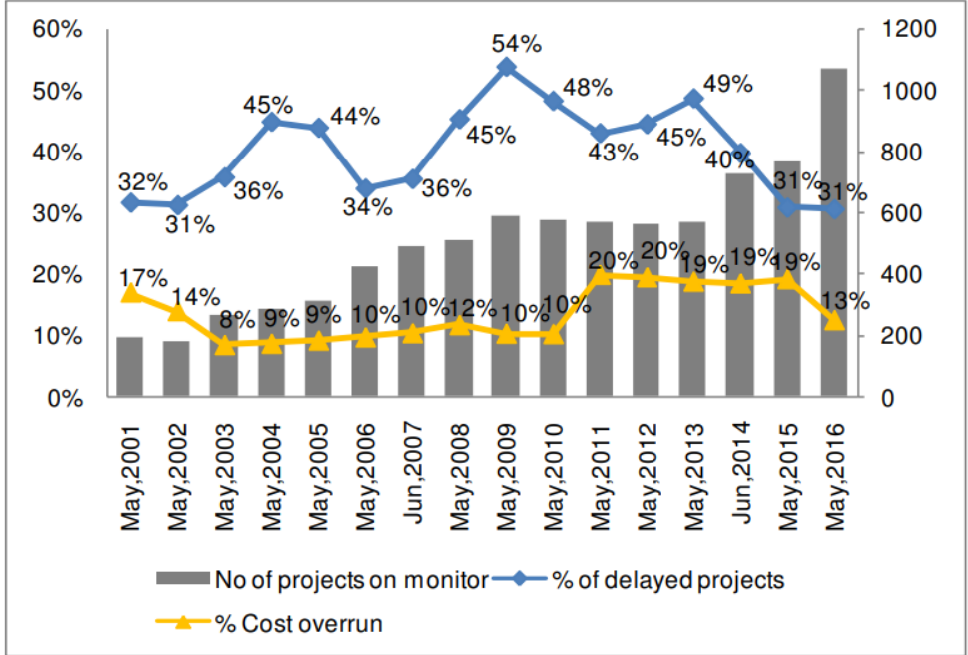
Figure 2. Delay and cost overrun trends in India over the past 15 years [17].